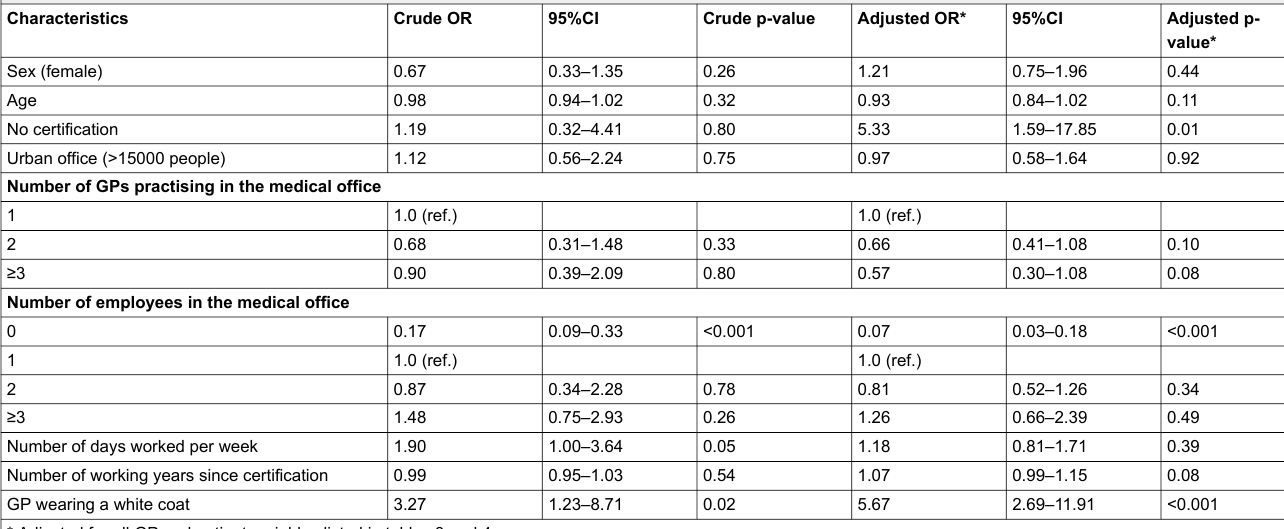
Table 4: Patient views on whether GPs should wear white coats according to GP characteristics (n = 1,327).